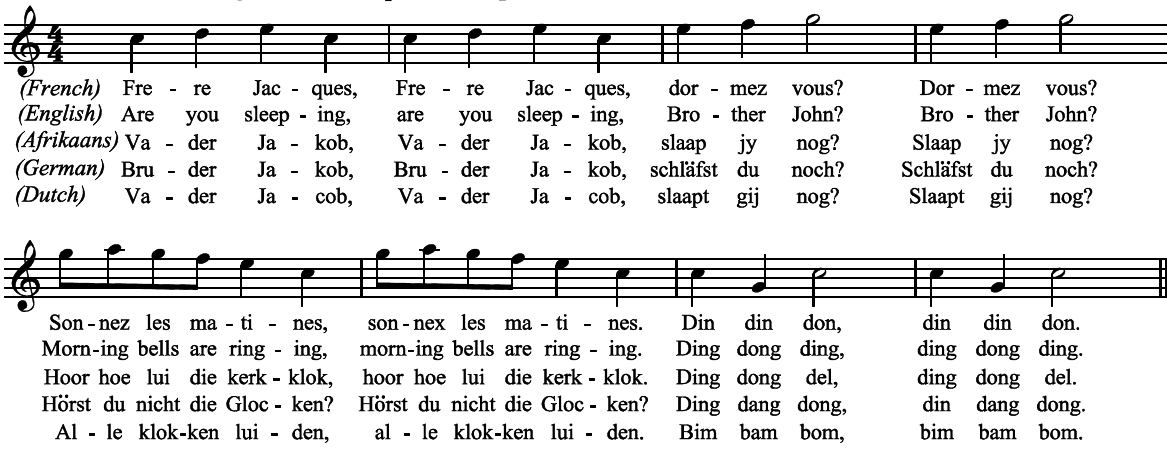
Fig. 2. Frère Jacques: European versions found in South Africa 12